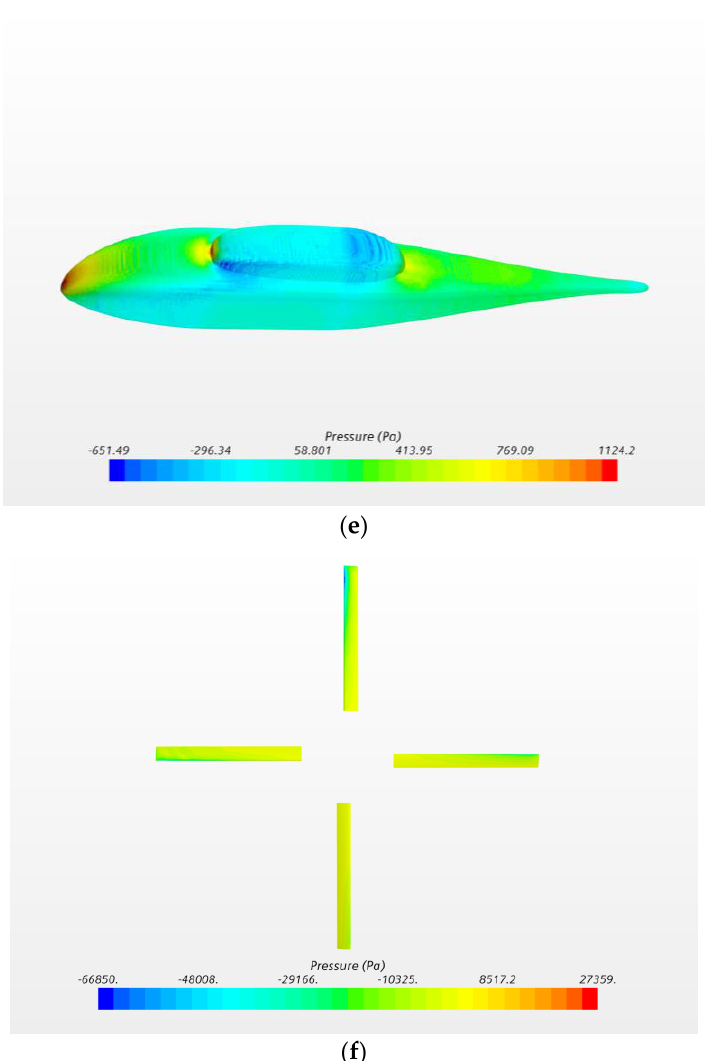
Figure 11. Pressure contours of Robin fuselage/rotor interference flow. ( a ) Fuselage/rotor, μ = 0.151. ( b ) Fuselage, μ = 0.151. ( c ) Rotor, μ = 0.151. ( d ) Fuselage/rotor, μ = 0.231. ( e ) Fuselage, μ = 0.231. ( f ) Rotor, μ = 0.231. Appl. Sci. 2020 , 10 , x FOR PEER REVIEW